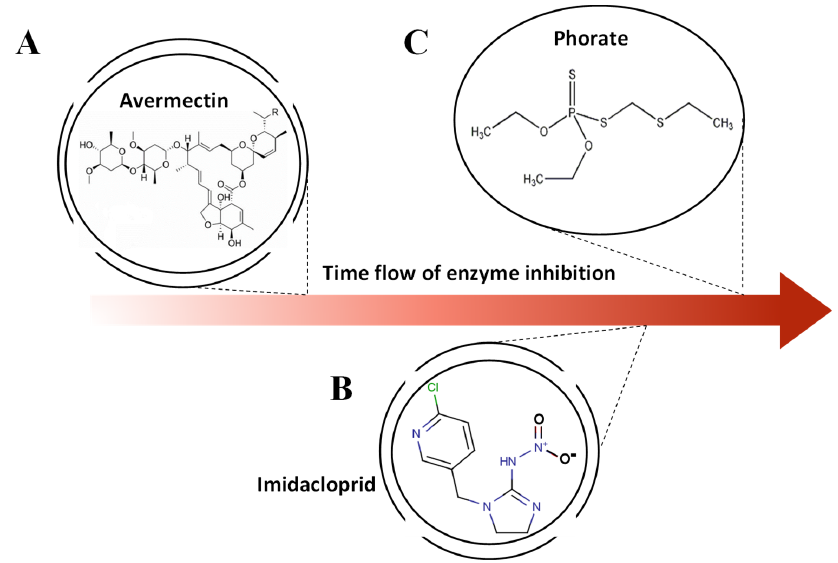
Figure 7. The various molecular structures of ( A ) avermectin, ( B ) imidacloprid, and ( C ) phorate and the aroused different efficiency in enzyme inhibition.